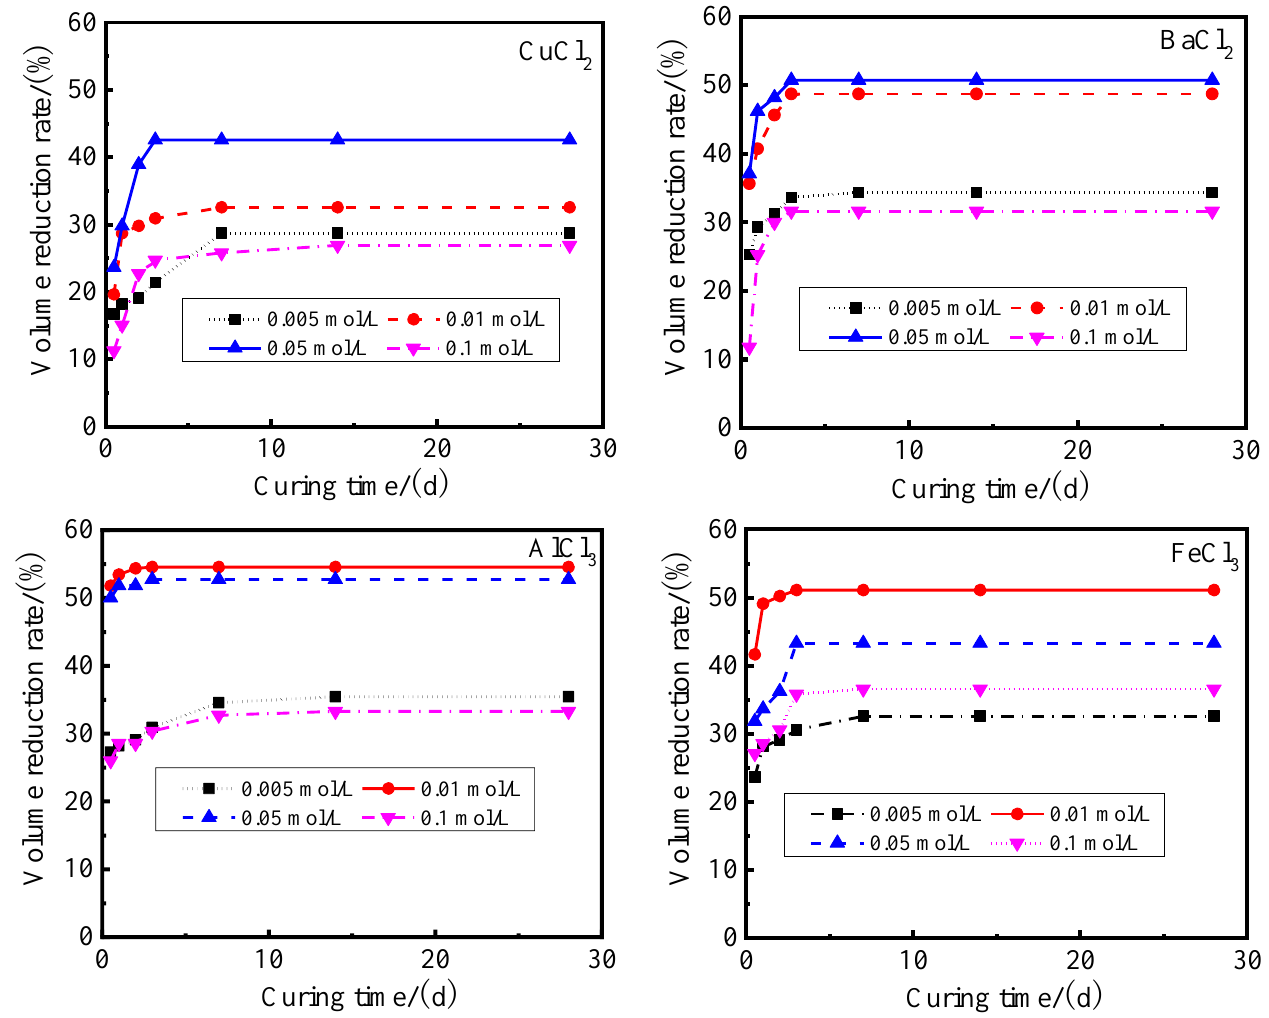
Figure 1. Volume reduction rate of modified PS samples based on different modifiers.